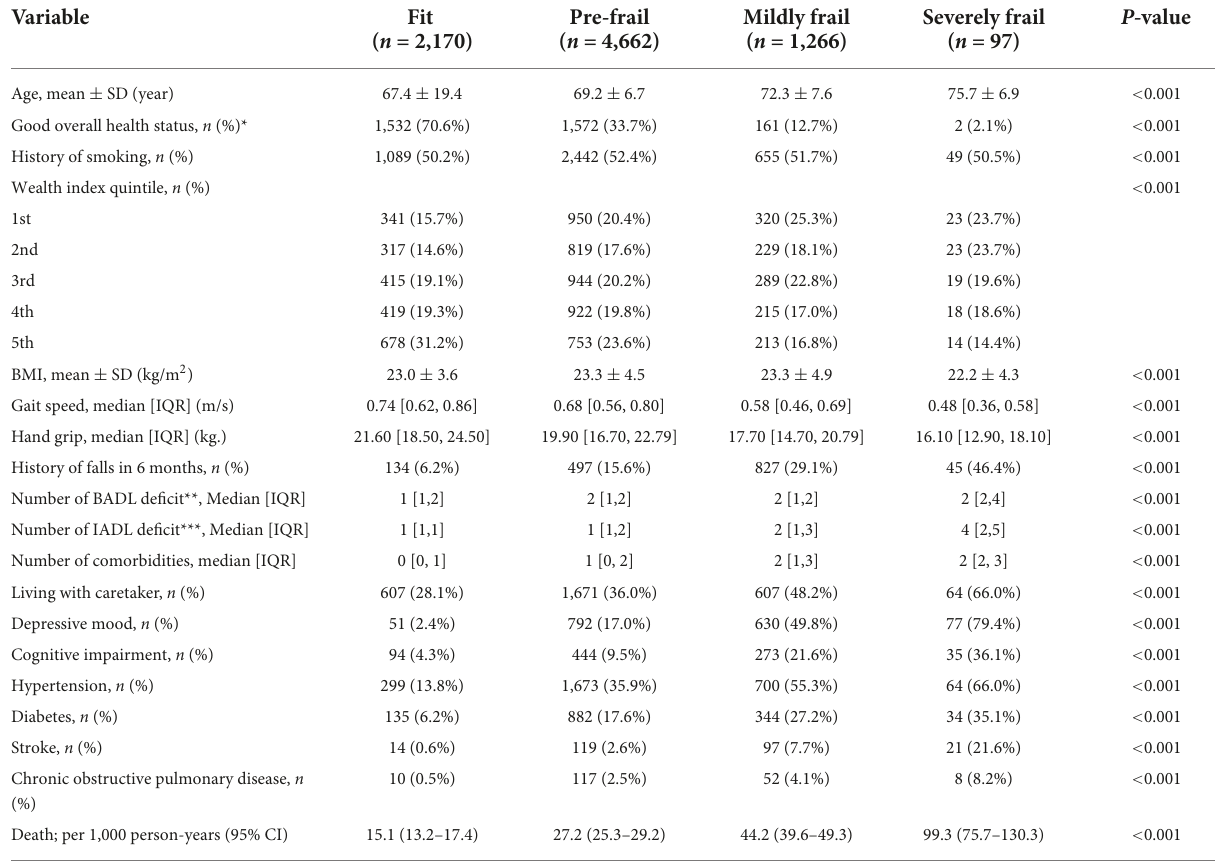
TABLE 1 Baseline characteristics of study participants by frailty status.